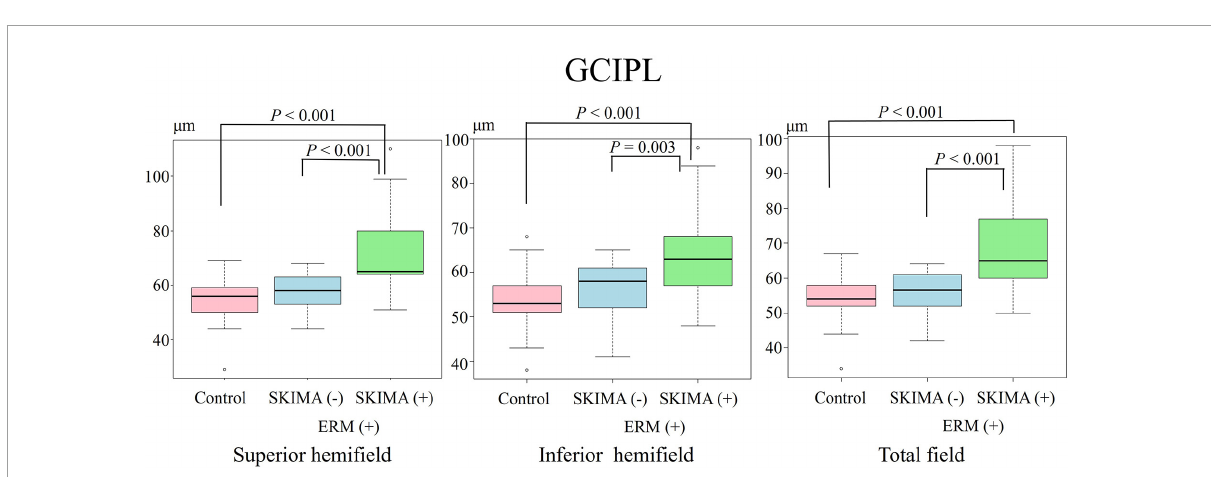
FIGURE3 Effect of SUKIMA on GCIPL thickness. Superior hemifield (Left panel) significant difference was found between the SUKIMA (+) and control groups and between the SUKIMA (+) and SUKIMA ( − ) groups. Inferior hemifield (Middle panel) significant difference was found between the SUKIMA (+) and control groups and between the SUKIMA (+) and SUKIMA ( − ) groups. Total field (Right panel) significant difference was found between the SUKIMA (+) and control groups and between the SUKIMA (+) and SUKIMA ( − )